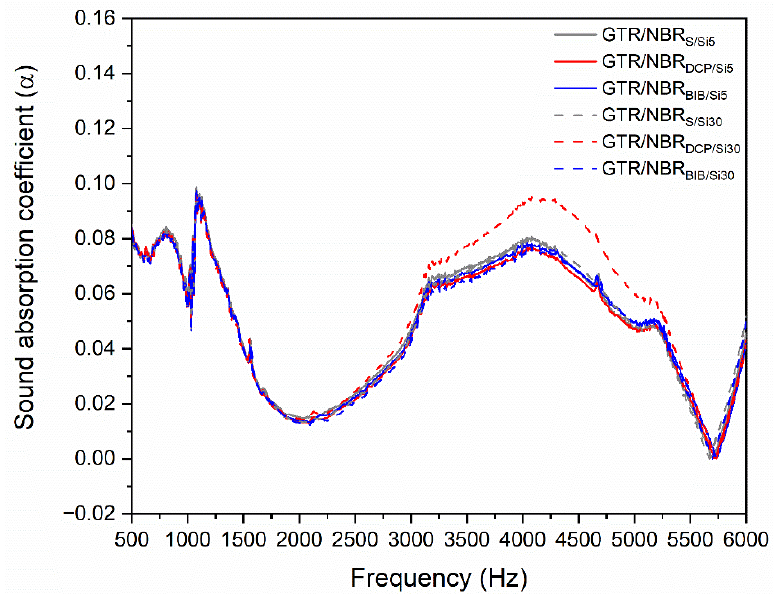
Figure 8. Sound absorption coefficient as a function of frequency for GTR/NBR samples.